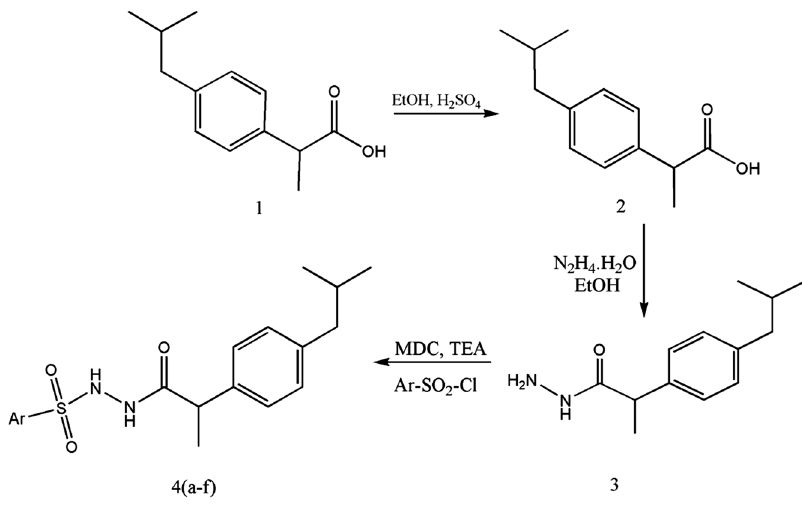
Figure 1. Reaction sequence for the synthesis of new Ibuprofen derivatives.